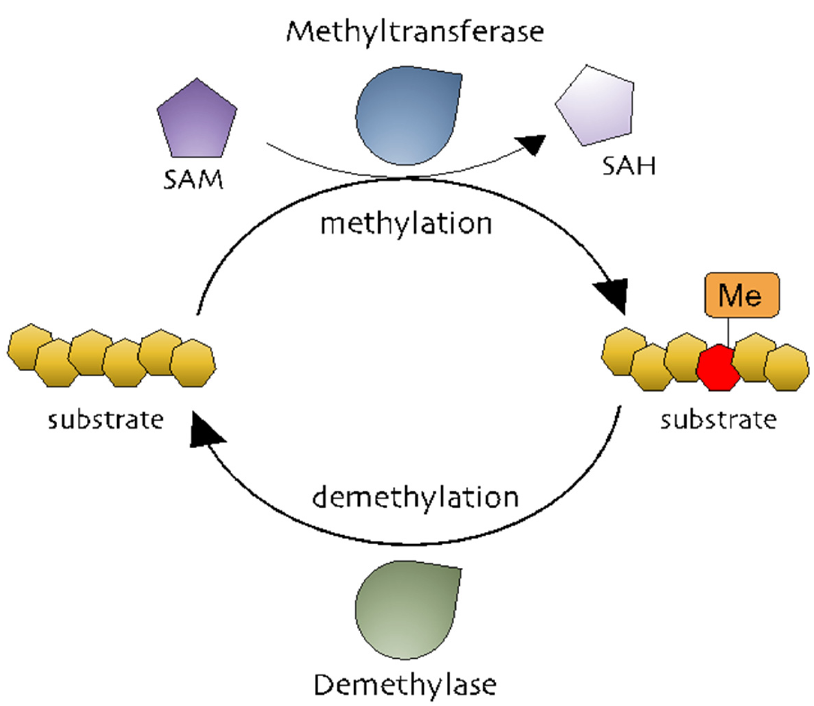
Figure 1. The methylation processes. Methyltransferases transfer a methyl group from a methyl donor (S-adenosylmethionine [SAM]) to a substrate. Methylated substrates can be demethylated by demethylases.